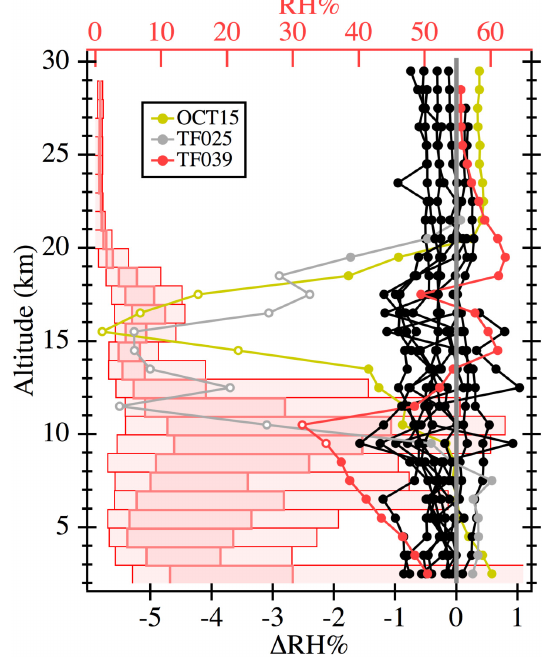
Fig. 9. Statistics of 1P for RS92-iMet (black) and RS92-RS92 (red) in 5-km altitude bins. The markers, bars, dashes and lines represent the same statistics of differences described for Fig. 5. Sta- tistically significant biases in RS92-iMet 1P are revealed above 15km. For RS92-RS92 1P only the standard deviation ranges in the 20–25 and 25–30km bins do not include zero.